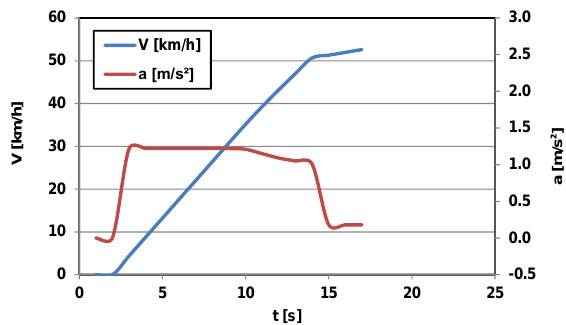
Fig. 6. Characteristics of speed and acceleration of the vehicle as a funct- ion of simulation time; a = 1.2 m/s 2